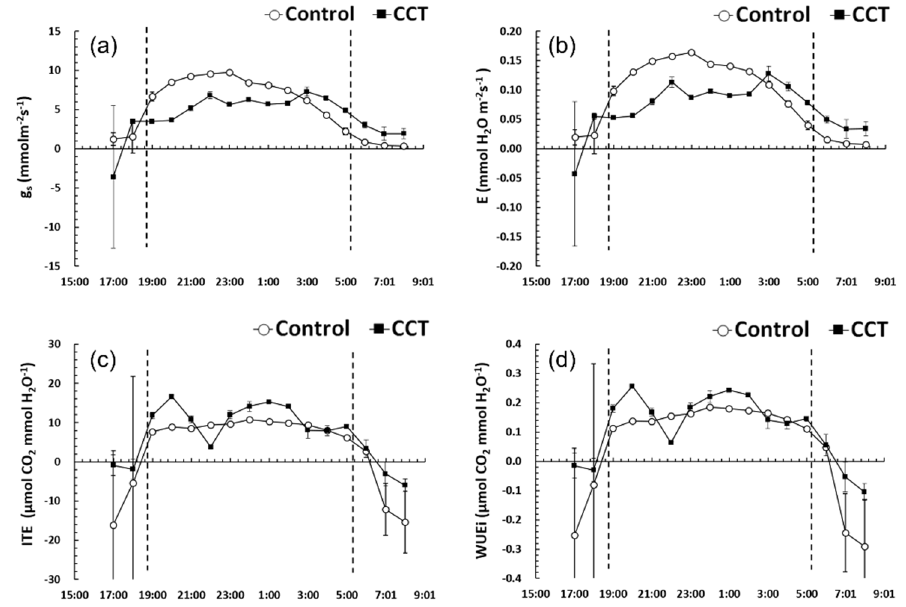
Figure 3. Changes of stomatal conductance (g s ) ( a ), stomatal transpiration rate (E) ( b ), instantaneous transpiration efficiency (ITE) ( c ), and intrinsic water use efficiency (WUEi) ( d ) of Sedirea japonica under control (CO 2 = 400 ppm) and CCT (climate change treatment, CO 2 = 650 ppm, temperature = control + 3 ◦ C) conditions. Each value is expressed as the mean ± SD ( n =